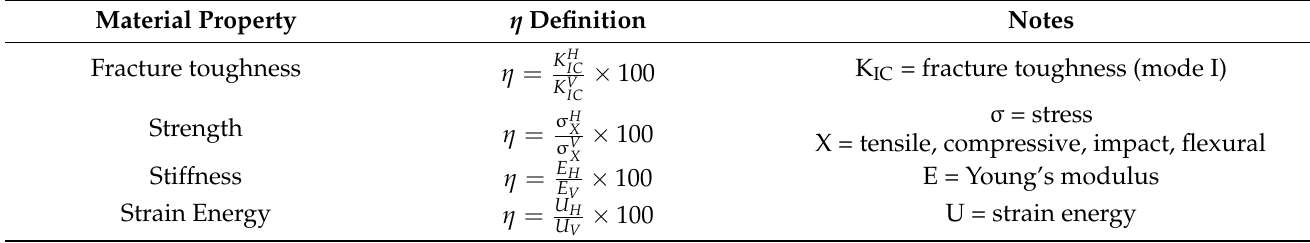
Table 1. Examples of healing efficiency definitions based on the recovery of different material